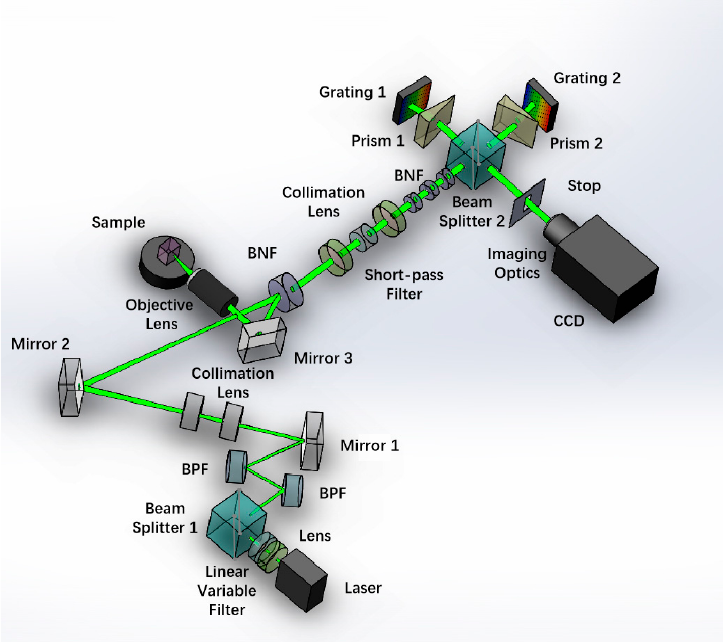
Figure 1. Schematic diagram of the echelle grating spatial heterodyne terahertz Raman spectrometer. Here, α is the angle of the prism and n is the refractive index of the prism.